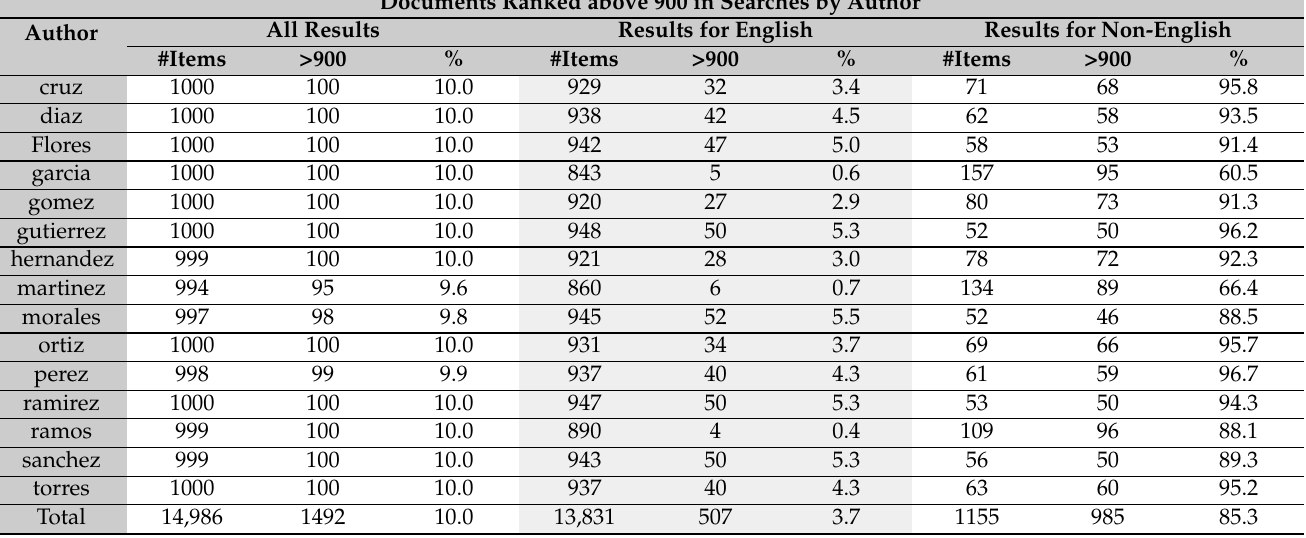
Table 3. Number of documents ranked above 900 in the case of searches by